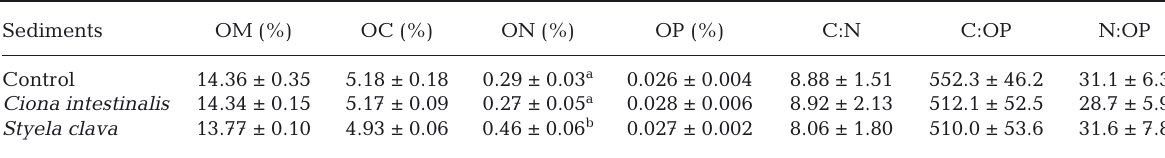
Table 3. Organic matter (OM), organic carbon (OC), organic nitrogen (ON), and organic phosphorus (OP) content, and C:N, C:OP, and N:OP ratios in sediments collected in the traps in Sanggou Bay, northern China, including controls (without ascidians) and traps with Ciona intestinalis or Styela clava . Values are means ± SE. Values in the same column with the same superscript letter are not significantly different as determined by Duncan’s test (p >